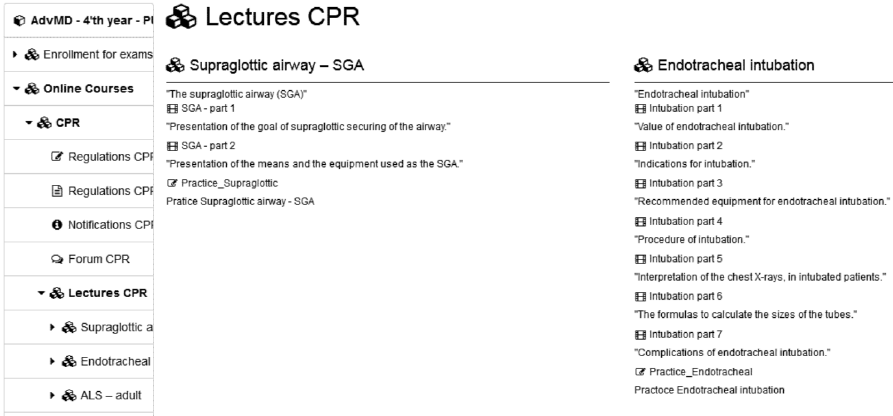
Figure 1. The lectures available for students by e-learning (SGA and